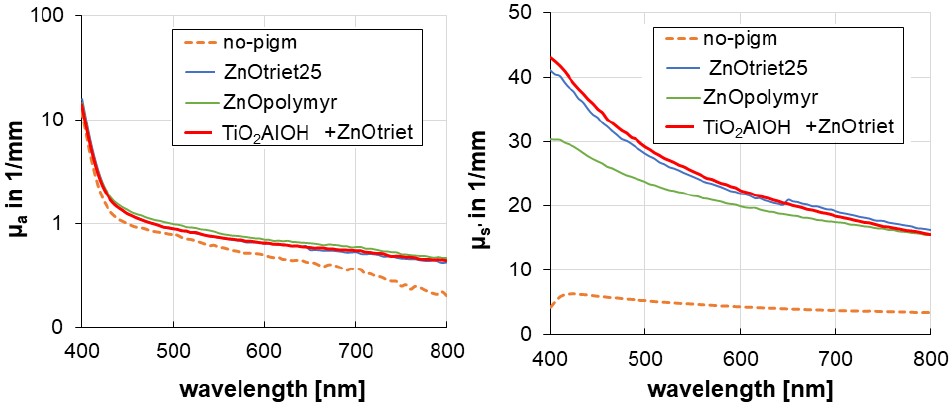
Figure 2. µ a and µ s ‘ for all creams without error bars for better comparison. The scale for µ a is loga-